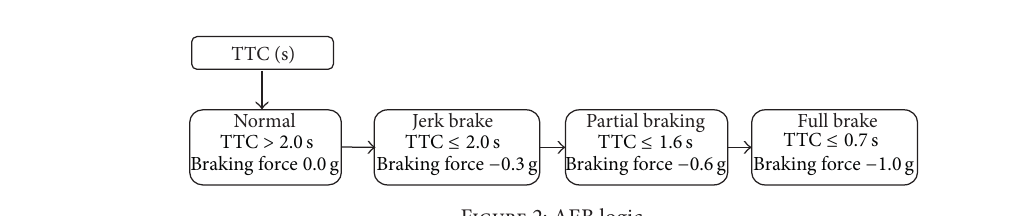
Figure 2: AEB logic.